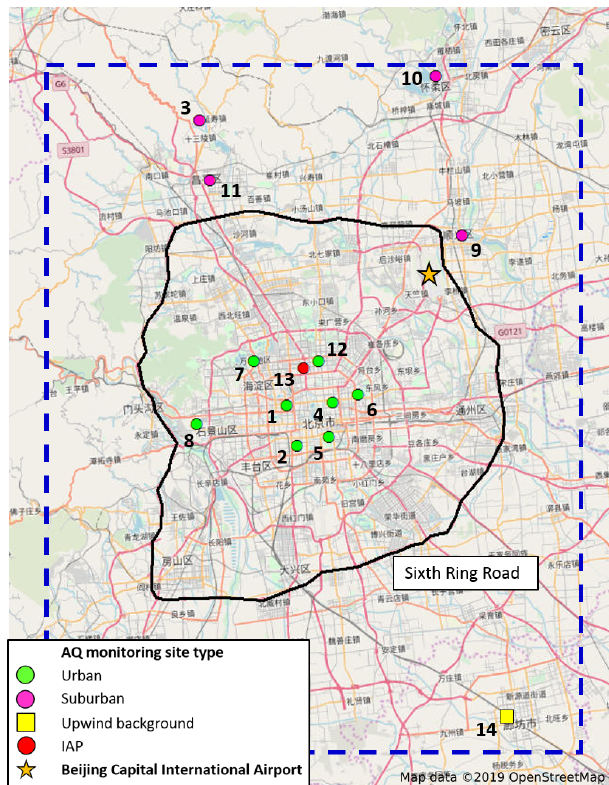
Figure 1. Map of Beijing (source: OpenStreetMap, 2019) with the modelling domain, measuring 75km × 90km, outlined (dashed blue line). Urban (green circle), suburban (pink circle), upwind back- ground (yellow square) and IAP (red circle) air quality monitor- ing station locations, including site numbers, are provided. Beijing Capital International Airport (yellow star) and the Sixth Ring Road (black line) are also highlighted. © OpenStreetMap